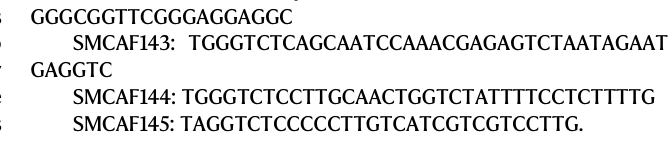
ability to be reshaped. Scale bars are 1cm. BUD-ELMs are mixed with glass powder toforma fi rmpastethathardenswhendehydrated (right),showingitspotentialas a cement-like agent. e Graph showing the fi nal Cd 2+ concentration after a six ppb Cd 2+ solutionwasincubatedwithorwithout Δ SpyTag BUD-ELMs.ItshowsthatBUD- ELMs are able to bind Cd 2+ from aqueous solutions. Error bars are centered on the mean value and represent the standard errors of three independent samples. Source dataare providedasaSource Data fi le. f Graphshowing the rate of glucose oxidation for BUD-ELMs that were incubated with SpyCatcher- holo -GDH, holo - GDH,orSpyCatcher- apo -GDH.Itcon fi rmsthatBUD-ELMsspeci fi callybindproteins fusedwithSpyCatcher.Errorbarsarecenteredonthemeanvalueandrepresentthe standard errors of three independent samples. Source data are provided as a Source Data fi